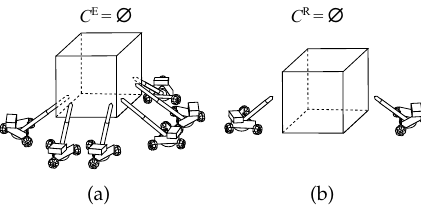
Figure 4. Examples of cases where ( a ) ECF is empty and ( b ) RCF is